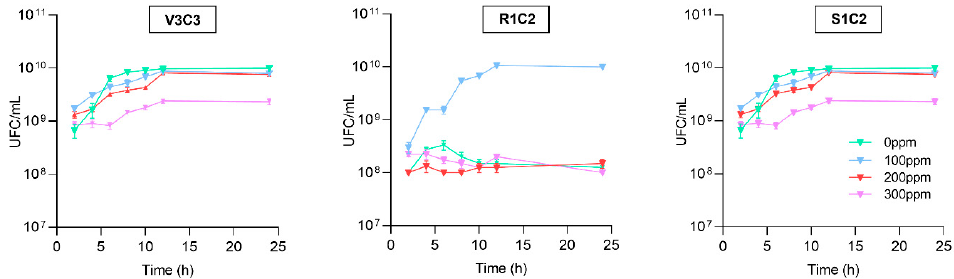
Figure 3. Bacterial growth kinetic characterization under cadmium conditions of selected hypertolerant bacteria. The HCdB strains were cultured in LB medium at 0, 100, 200, and 300 ppm of CdCl 2 , and the CFU/mL were quantified at 2, 4, 6, 8, 10, 12, and 24 h (h). Each point represents the means of three replicates ± SE. The graphics were performed using GraphPad software v.8.0.1 by Dotmatics, San Diego, CA, USA.